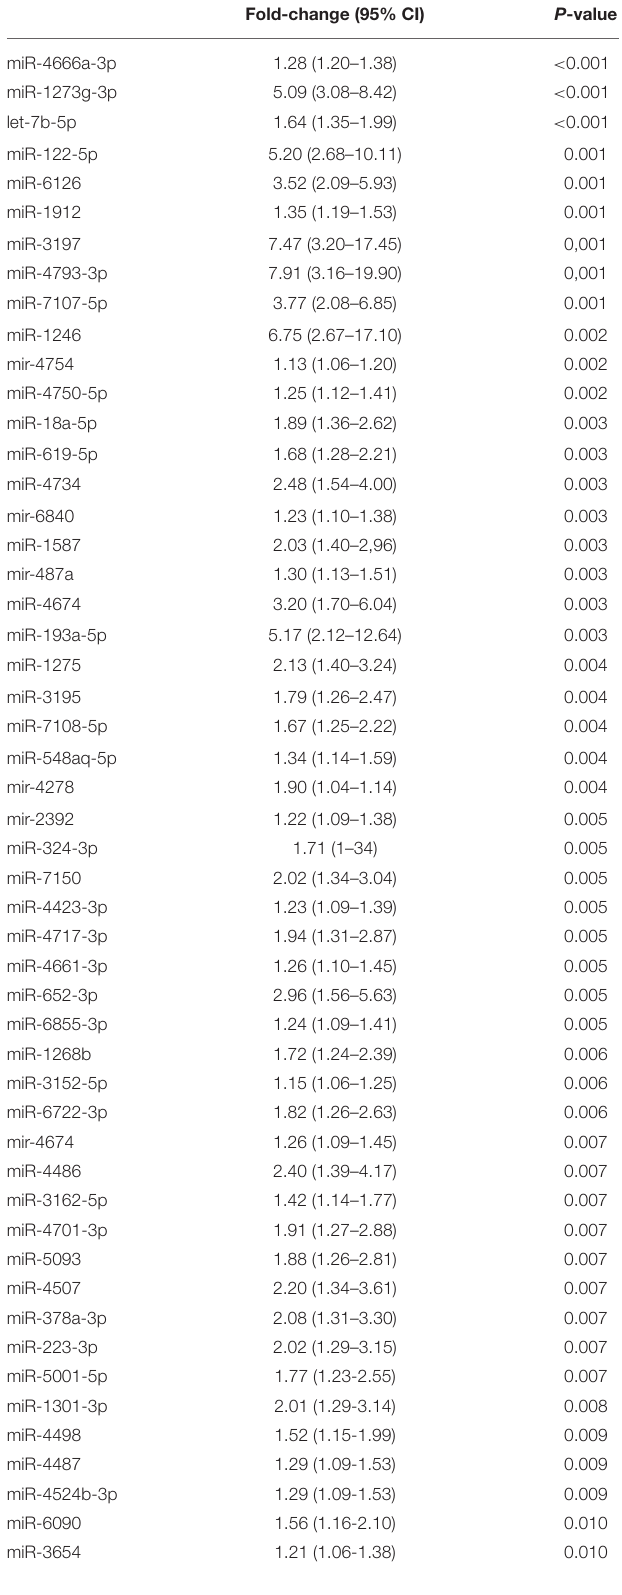
TABLE 2 | MicroRNA over-expressed in sets of pooled plasma from patients with pancreatic cancer compared to those from healthy controls. Fold-change (95%